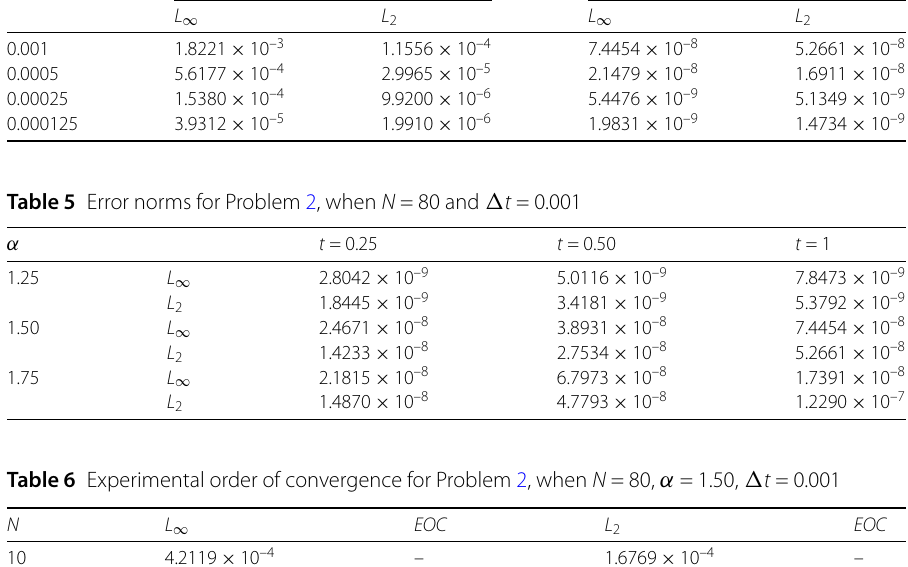
Table 4 Error norms for Problem 2 at t = 1 with N = 80, α = 1.50 (cid:2) t Method in [1]